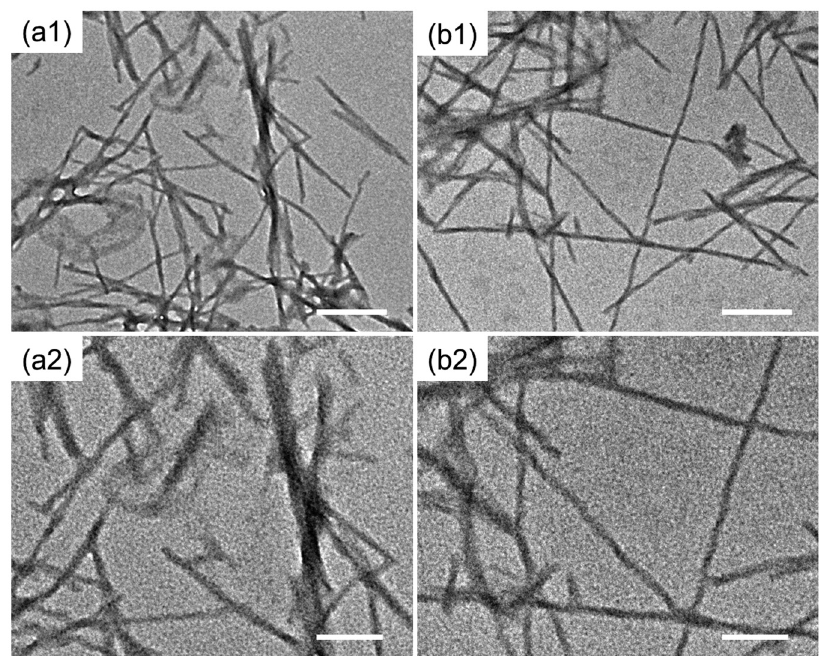
Figure 4: TEM images of ( a1 and a2 ) KKRW6 and ( b1 and b2 ) KKRW6 - F peptide self - assemblies. Scale bars: ( a1 and b1 ) 200 nm and ( a2 and b2 ) 100